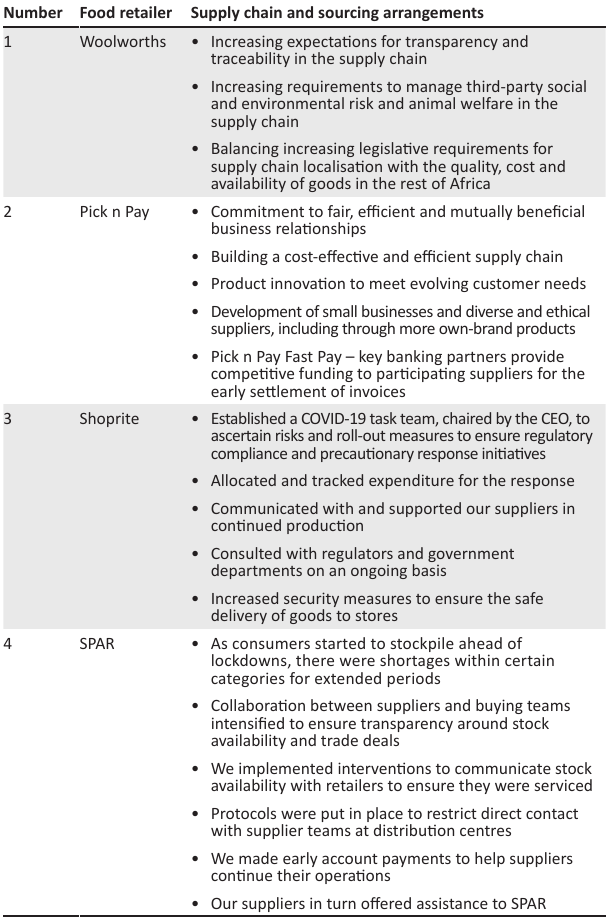
TABLE 3: Overview of how some major South African food retailers responded to the COVID-19 pandemic to safeguard their supply chains. Number Food retailer Supply chain and sourcing